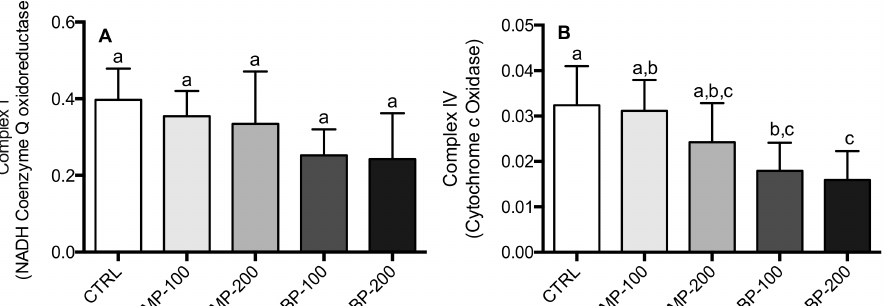
Figure 3. Activities of complexes I and IV of the mitochondrial electron transport chain of testes of F1 generation. The enzymatic activities are expressed as nmol oxidized NADH ( A ) and nmol cytochrome c oxidized ( B ). The results are M ± SD of 7–10 independent experiments performed in duplicate. The values marked with the same letter are not statistically significant as determined by the Tukey’s post hoc test ( p <